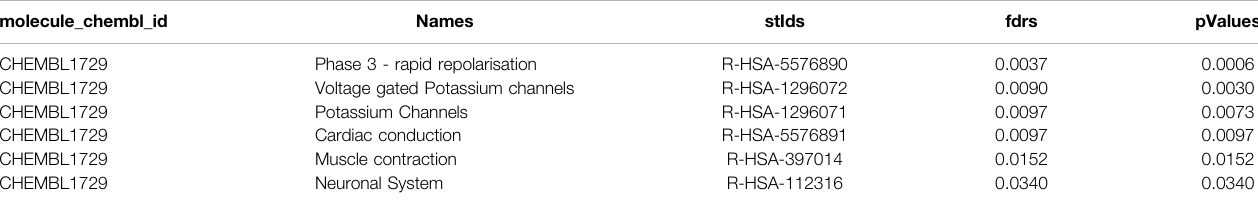
TABLE 1 | Example of the work fl ow output for cardiotoxic compound CHEMBL1729 (Cisapride) showing top 5 pathways. The output table consist of the compound identi fi er, pathway names, pathway identi fi ers, and statistical values such as fdrs and pValue for all signi fi cantly modulated pathways.